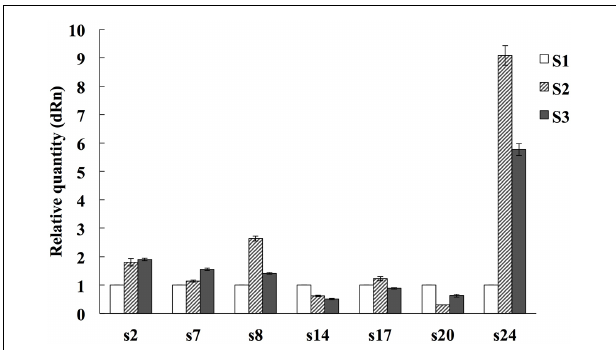
FIGURE 5 | Quantitative Real time PCR analysis on mRNA transcription of the selected expressed proteins during alfalfa flower development. S1: pre-pollinated stage (fully opened with the keels still closed); S2: pollinated stage (2 h after pollination); S3: post-pollination senesced stage (24 h after pollination). The average expression of each gene was calculated relatively to the reference gene β -actin. This experiment was conducted three biological replicates. The relative expression value of each gene was normalized to an endogenous control and calculated using the 2 − (cid:49)(cid:49) CT methods. All primer sequences are listed in Supplementary Table